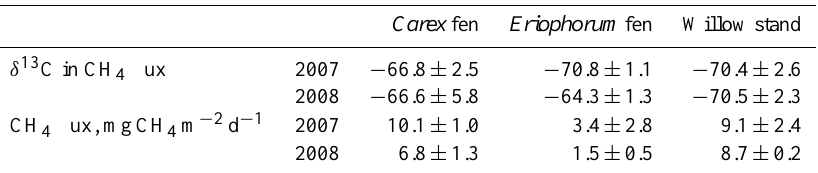
Table 2. Isotopic signature ( 13 C) of δ 13 C in CH 4 emission of various tundra wetland types and magnitude of CH 4 flux during isotope sampling. Data are growing season means ± SD, n = 3.